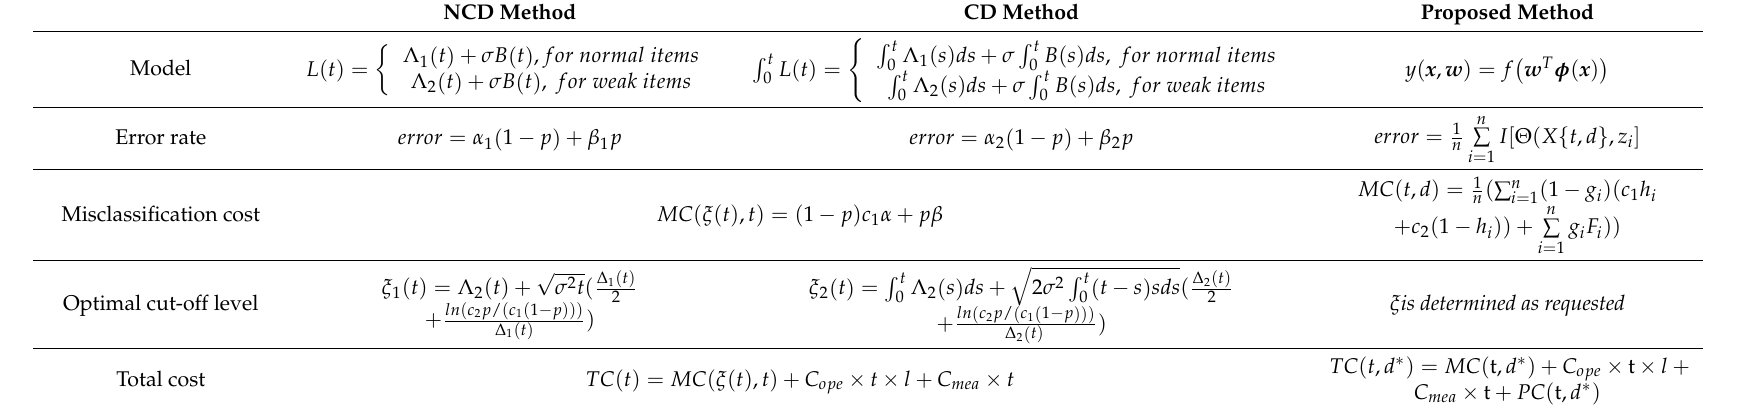
Table 2. Comparison of the proposed method with the NCD and CD